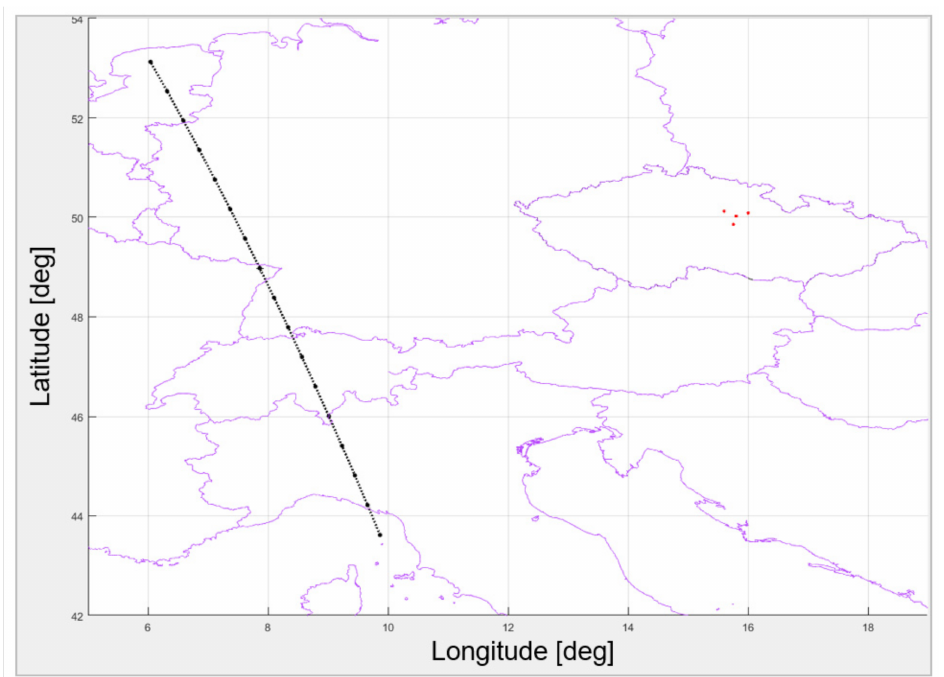
Figure 8. The location of the ESM MLAT system in the Czech Republic (four red dots) and the real trajectory (black dots) of the SAR emitter (Sentinel-1), whose coordinates were used for the error analysis. This figure shows that the baseline is much smaller than the distance from the SAR